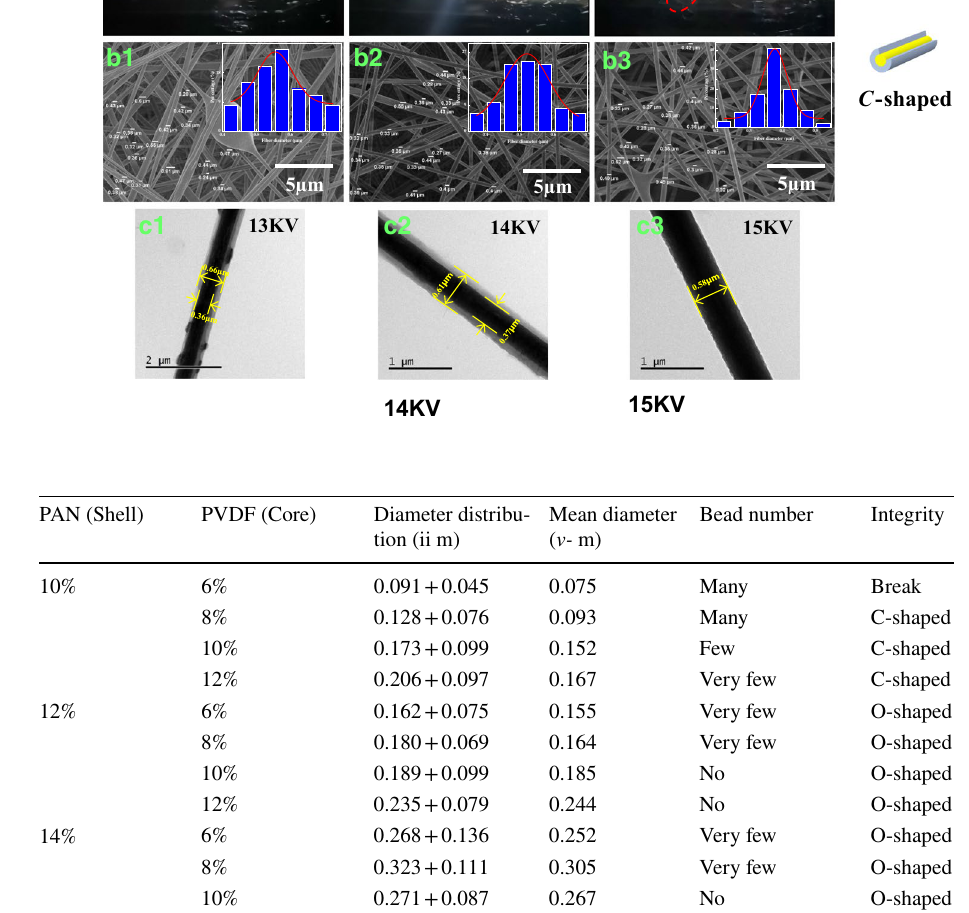
Fig. 2 a The optical images dur- ing the electrospun process, b the SEM images and c the TEM images of the fibers at different voltages